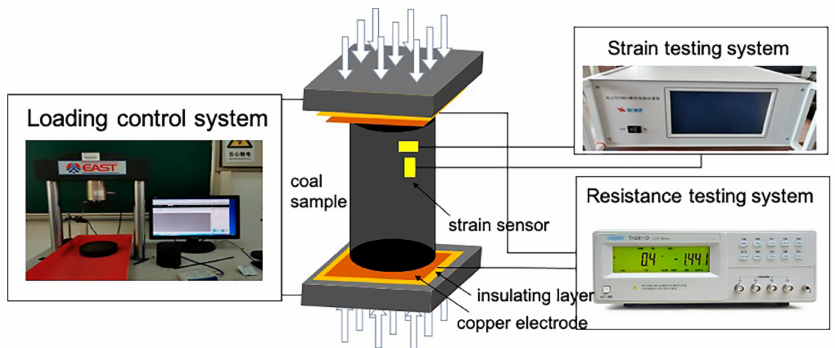
Figure 3. Experimental system of tectonic coal test.